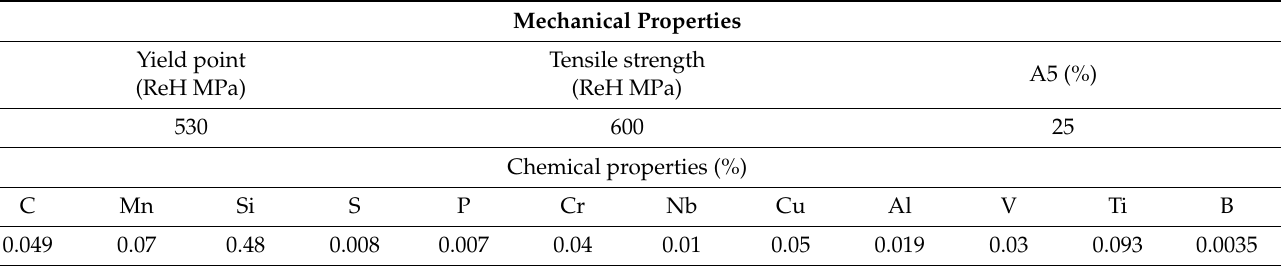
Table 2. Mechanical properties of FLUXOFIL 14HD.